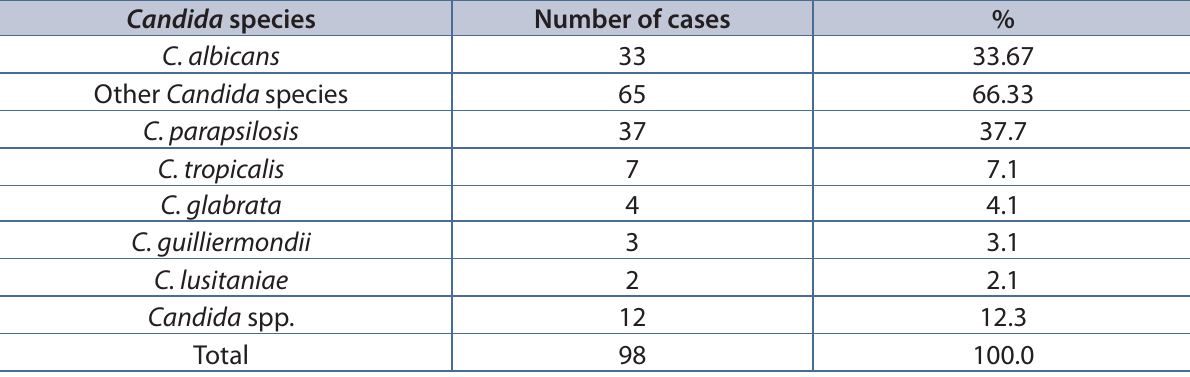
Table 1. Identification of Candida species isolated from candidemia patients admitted to Botucatu Medical